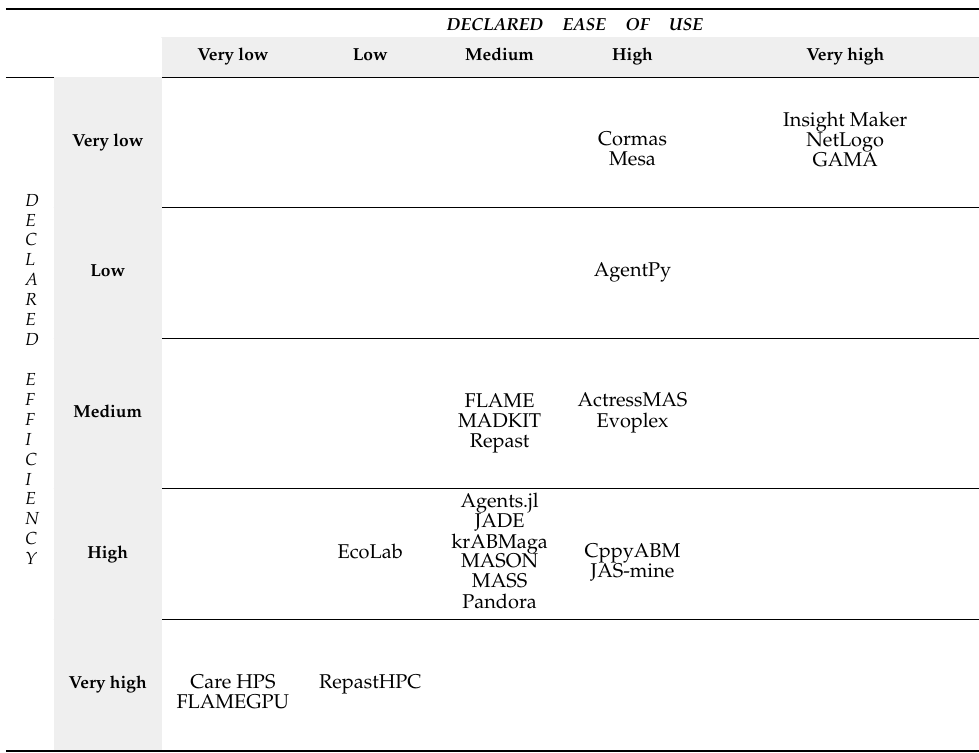
Table 5. Trade-off between the declared ease of use and efficiency of the ABM